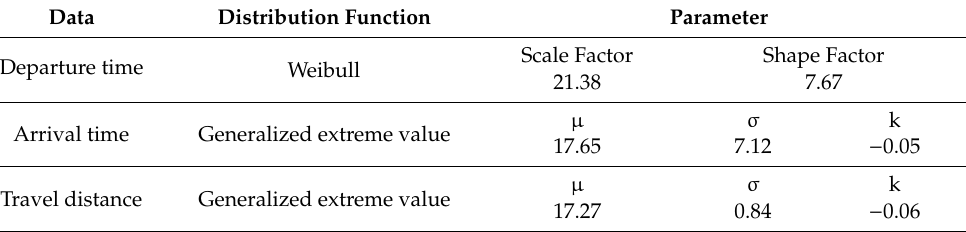
Figure 7. The boxplot of hourly wind speed. Table 1. Distribution function parameters of the travel behavior